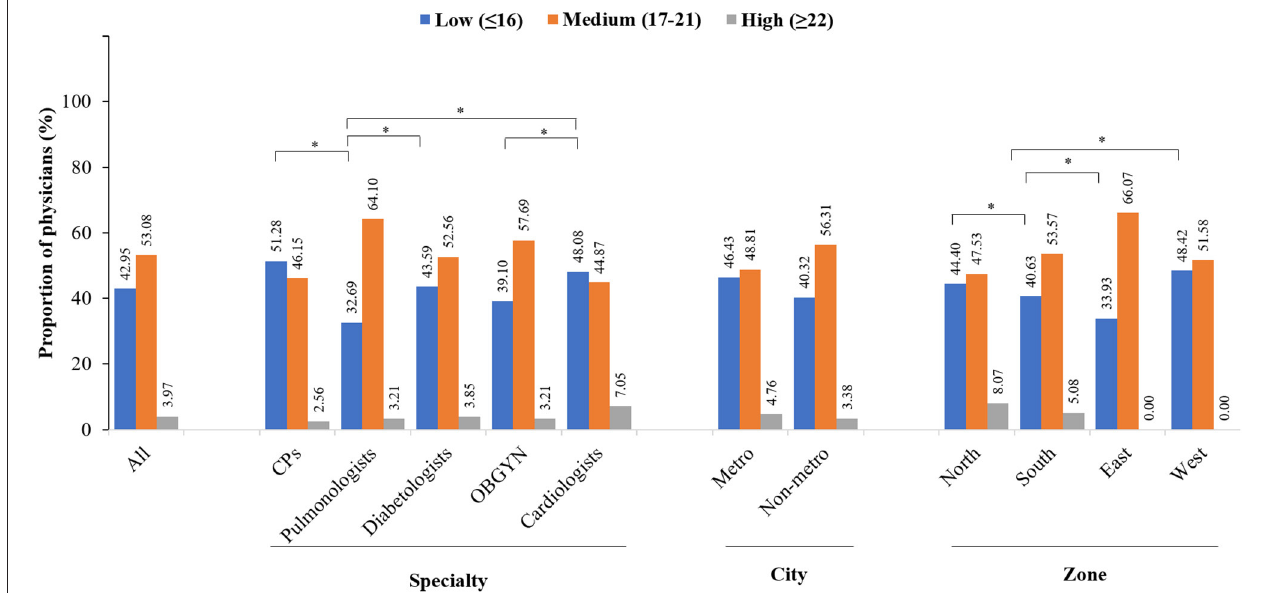
FIGURE 1 | Overall awareness of physicians. *Indicates P < 0.05. CPs, consulting physician; OBGYN, obstetricians and gynecologists.